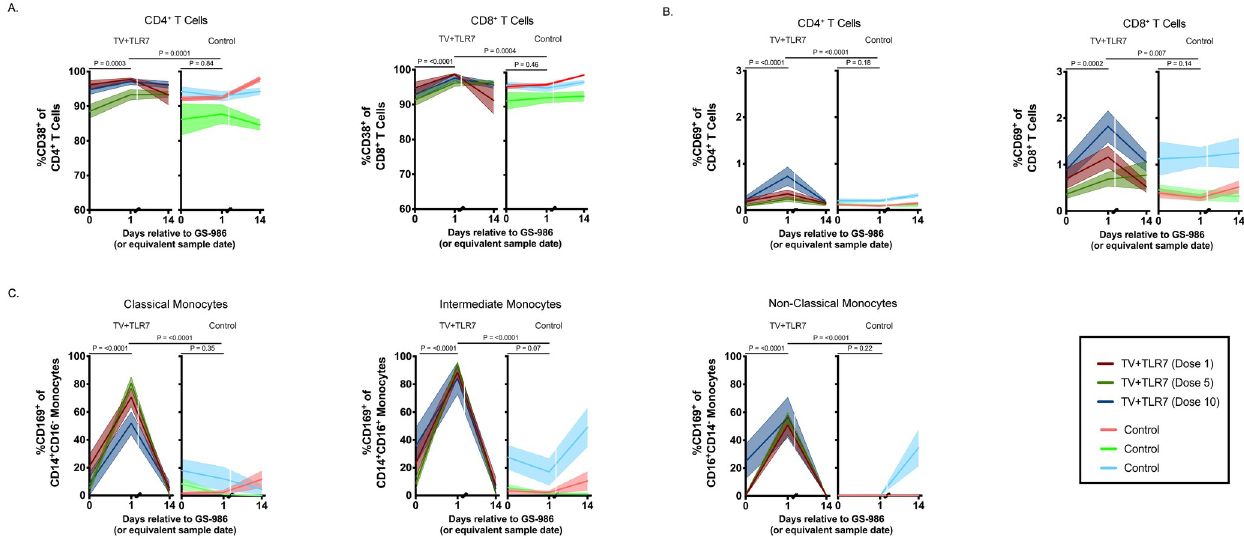
Fig 6. Immunological response to repeated oral GS-986 administration in SIV-infected, ART-treated infant RMs. Frequency of (A) CD38 + and (B) CD69 + peripheral CD4 + and CD8 + T cells immediately prior to, 1 day post, and 14 days post oral GS-986 dose 1, 5, and 10 in TV+TLR7 or equivalent sample day in control RMs. (C) Frequency of CD169 + classical, intermediate, and nonclassical monocytes in TV+TLR7 and control RMs. Dose number is indicated by color. Bars represent mean ± SEM. Statistical analysis was performed using a Wilcoxon matched-pairs signed rank test.